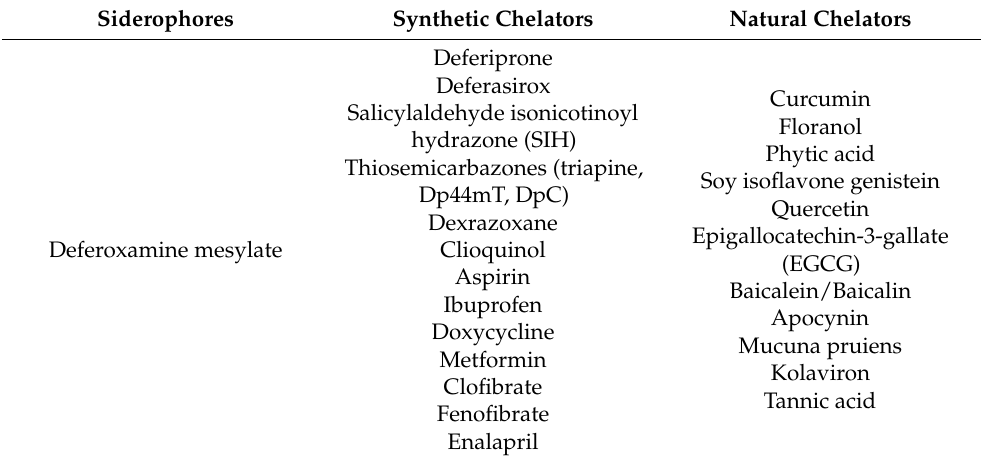
Table 2. List of Iron